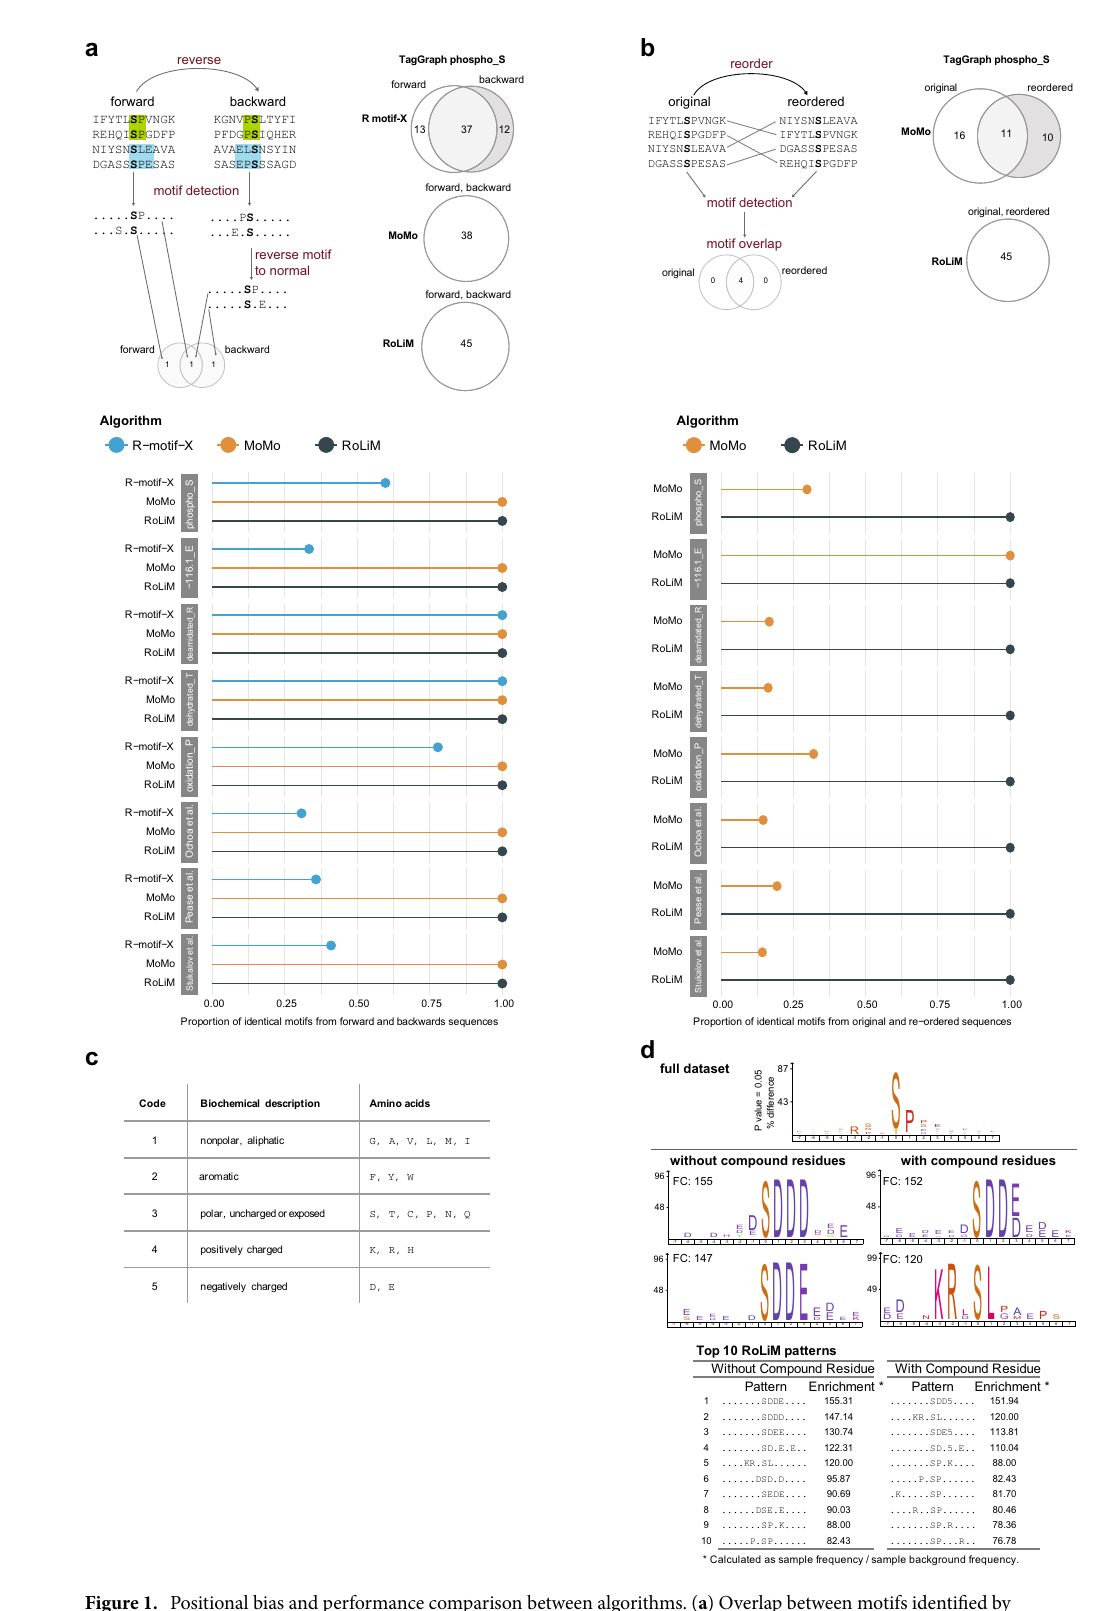
Figure 1. Positional bias and performance comparison between algorithms. ( a ) Overlap between motifs identified by rmotif-X, MoMo, and RoLiM in original and reverse sequence datasets. ( b ) Overlap between motifs identified by rmotif-X, MoMo, and RoLiM in original and reordered sequence datasets. The proportion of overlap shown in the lollipop graph was calculated as the number of the same motifs found in both forward and reverse foregrounds/the sum of all unique motifs found in both foregrounds. See online Methods for details. ( c ) Compound residue classification implemented in RoLiM. ( d ) Top ten enriched phopsho-serine motifs identified by RoLiM in the dataset from Zadora et al. with and without compound residues